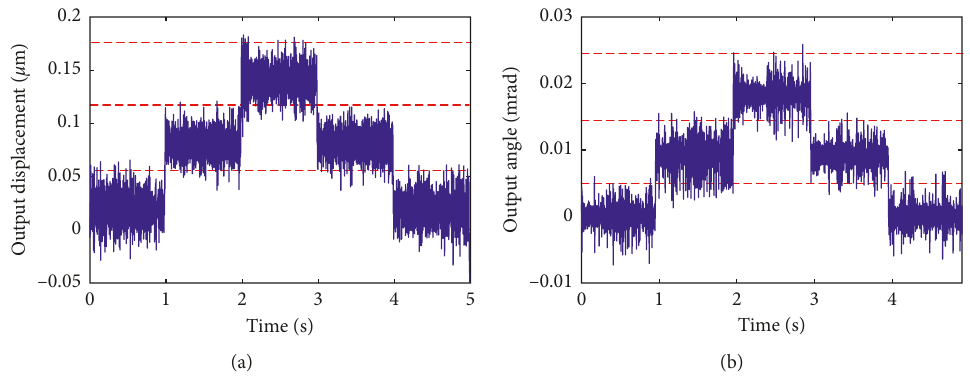
Figure 22: Multistep response for the resolution test: (a) X / Y -axis; (b) θ